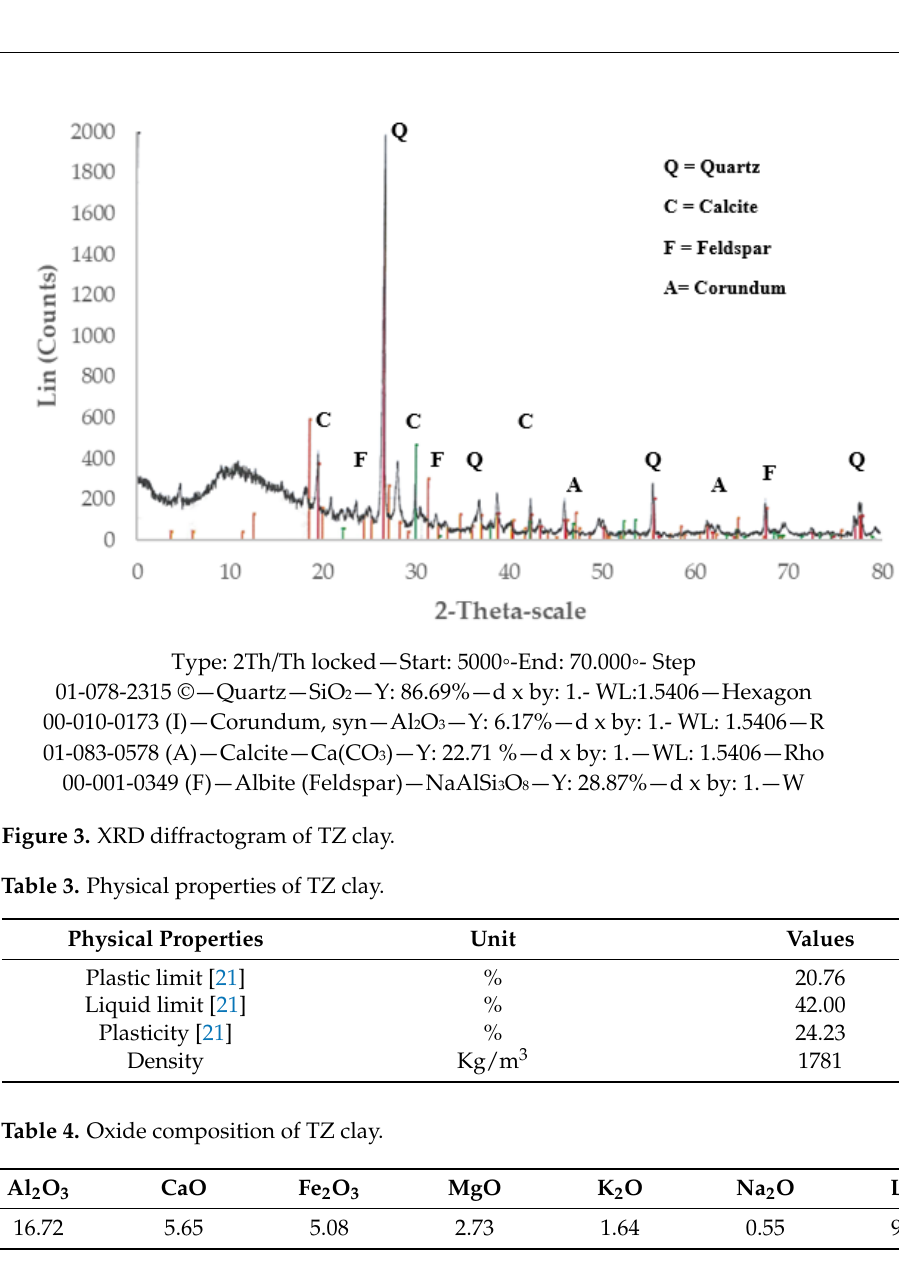
Table 6. Oxide composition of dolomite limestone. Table 5. Particle size distribution of